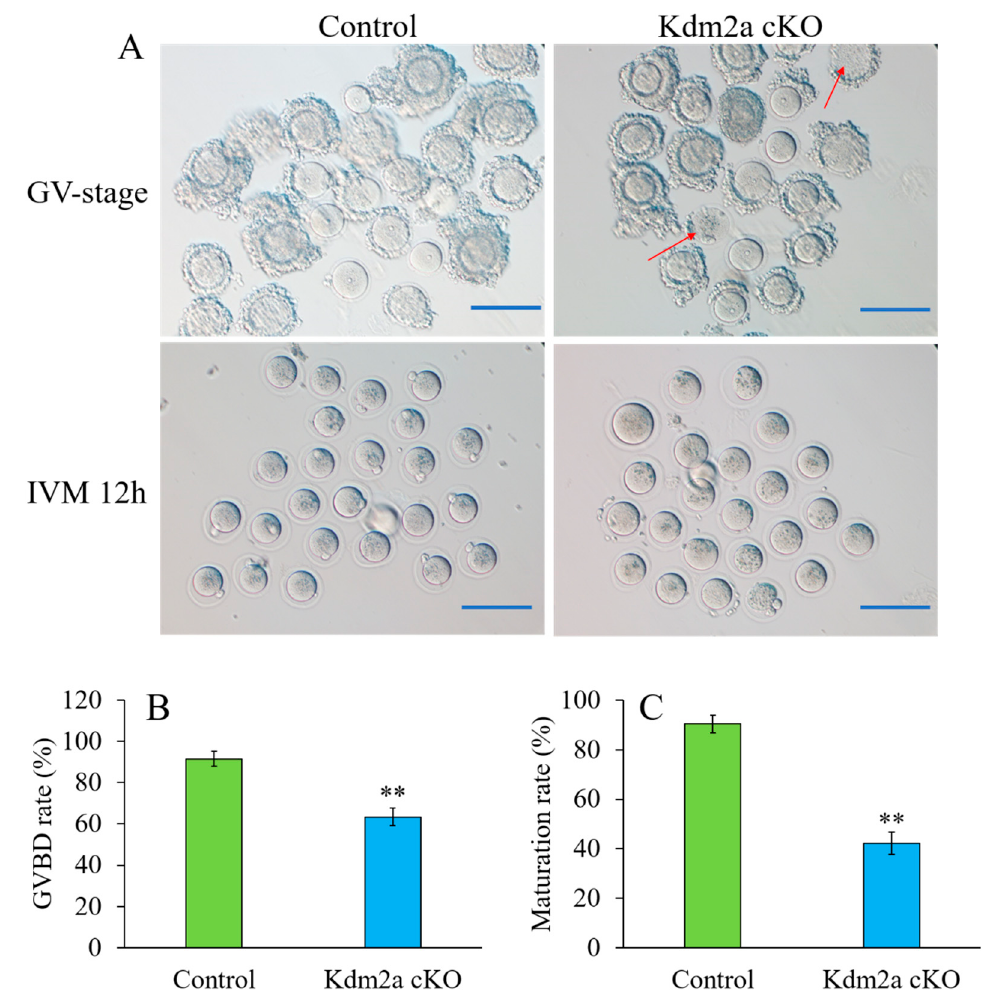
Figure 5. Oocytes from Kdm2a cKO mice were partially arrested to complete meiotic maturation. ( A ) Immature GV oocytes isolated from 4-week-old control and Kdm2a cKO mice were cultured in vitro to check the maturational progression, a few polar bodies can be excluded of Kdm2a cKO oocytes after 12 h culture. The arrow points to cytoplasmic damage. ( B , C ) Quantitative analysis of GVBD rate and Pb1 extrusion rate in control (n = 106) and Kdm2a cKO (n = 94) oocytes. The graph shows the mean ± SEM of the results obtained in three independent experiments. ** Extremely significant difference ( p < 0.01). Scale bars, 200 μ m.